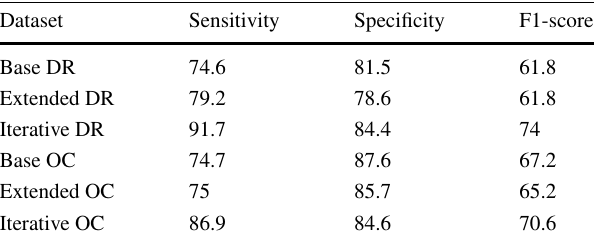
Table 11 Results with original, iterative and extended